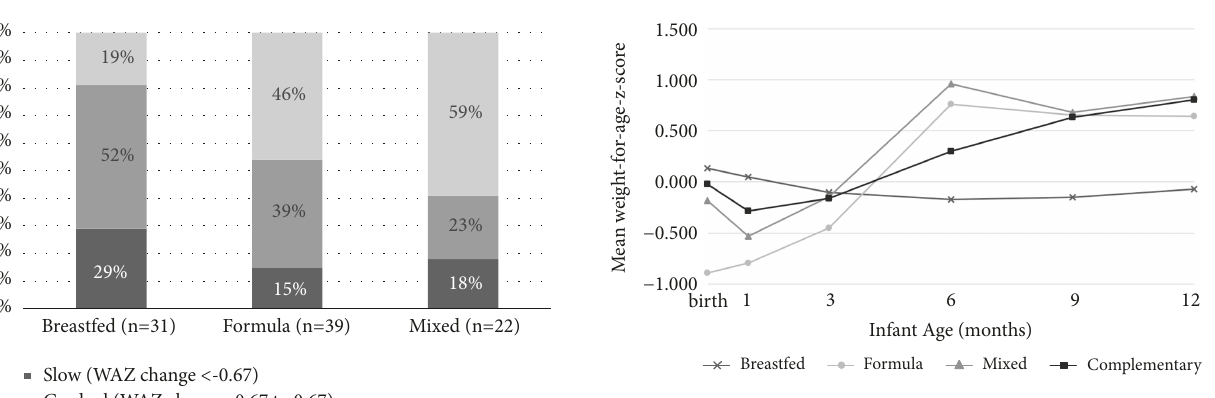
Figure 2: Estimated mean weight-for-age z-scores at birth, 1 month, 3 months, 6 months, 9 months, and 12 months (n=60) . Lines represent different infant feeding practices across time. Z-scores reflect adjustment for caretaker age, race, and education (p < 0.05). There were some infants considered underweight ( < 5 percentile) at birth (8.3%), at 1 month (11.9%), at 3 months (6.3%), at 6 months (1.5%), 9 months (0%), and at 12 months